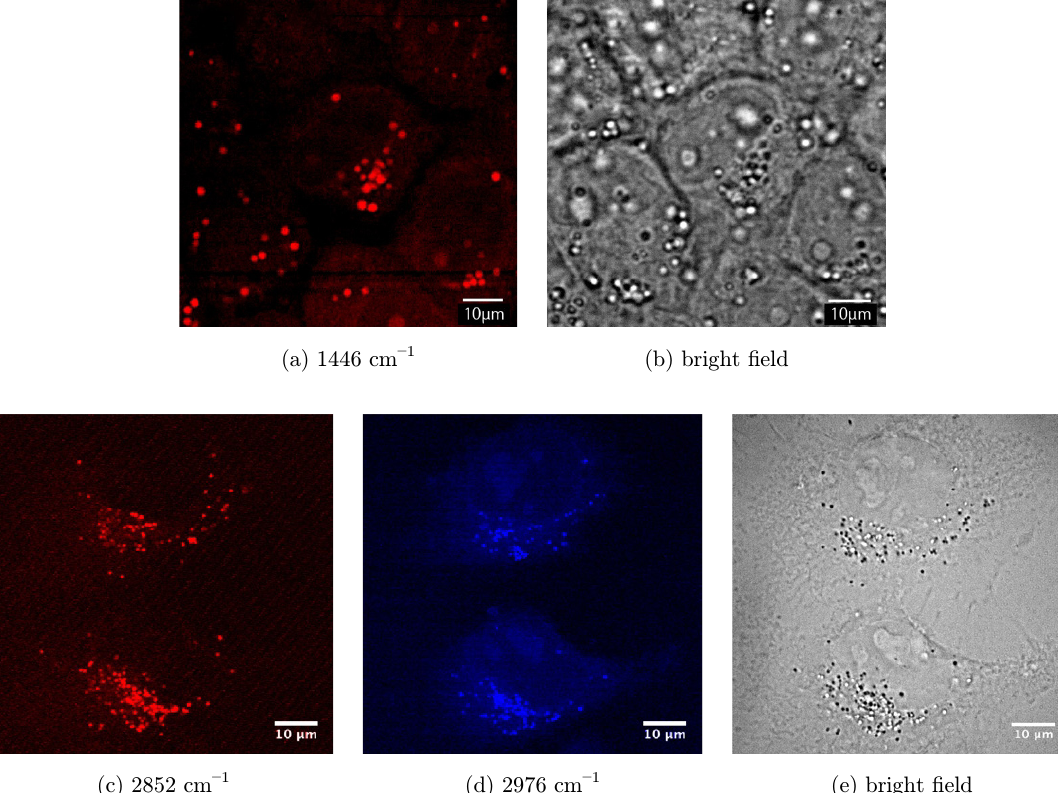
Fig. 2. (a) CARS and (c) and (d) SRS imaging at two frequencies on HeLa cells, where each image is compared with a bright ¯eld (b) and (e) image taken separately. The red contrast shows lipid structures, while the blue contrast represents